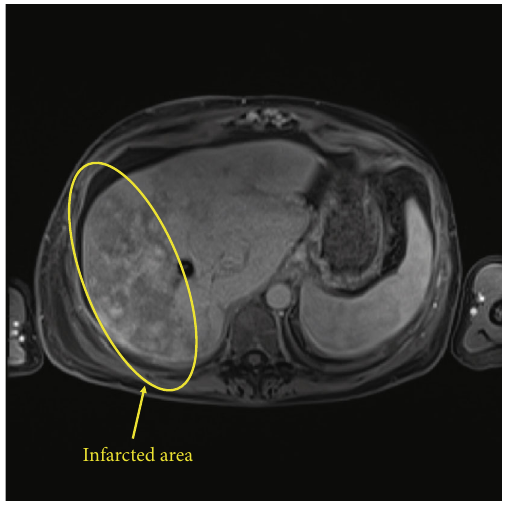
Figure 1: Preoperative MRI demonstrating multifocal infarction of the right lobe of the liver, with TIPs in